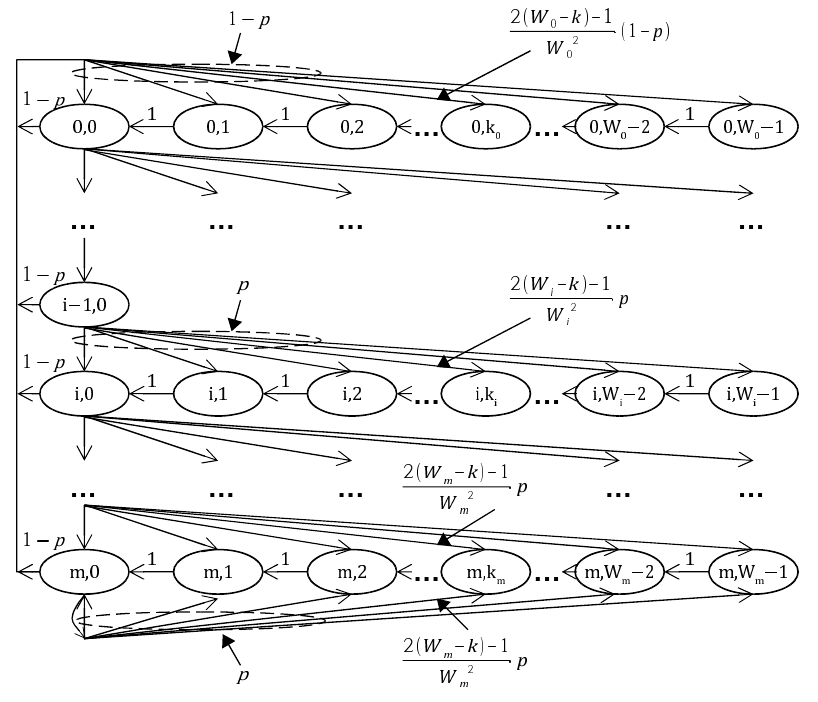
Figure 6. A simplified Markov Chain model for the backoff window size in MLA-S when the two stations are affiliated with an